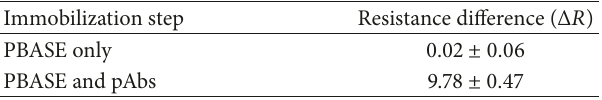
Table 2: Effect of immobilization steps on the resistance difference of SWCNT-based biosensor.